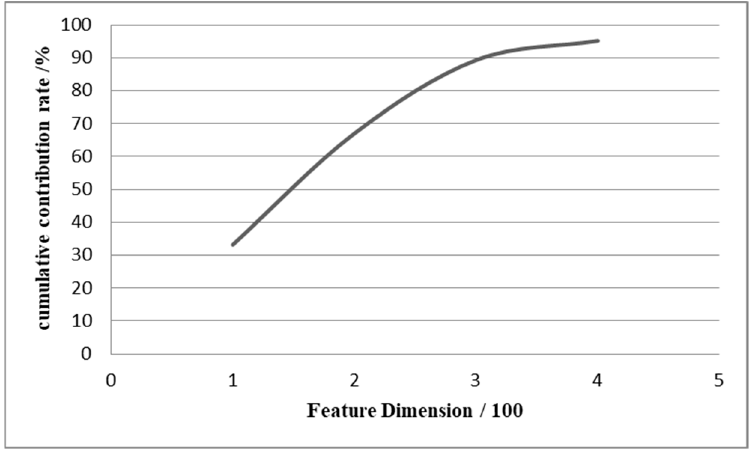
Figure 3. The feature dimension of 90% cumulative contribution rate.